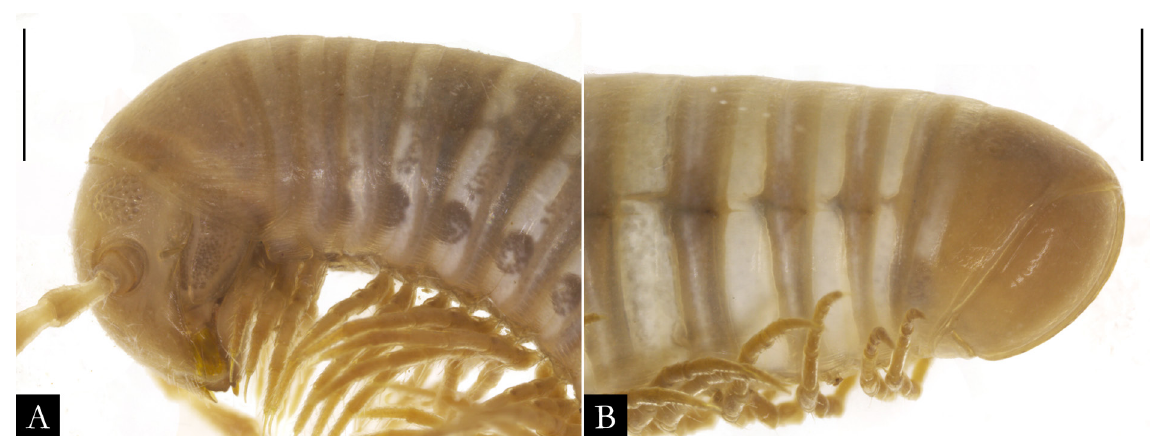
Fig. 85. Pseudonannolene lundi Iniesta & Ferreira, 2015, holotype, ♂ (ISLA 8684), in lateral view. A . Anterior region. B . Posterior region. Scale bars = 1